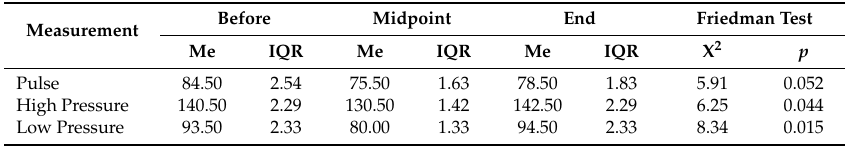
Table 3. Physiological measurements and the Friedman test before, midpoint, and at the end of the intervention.